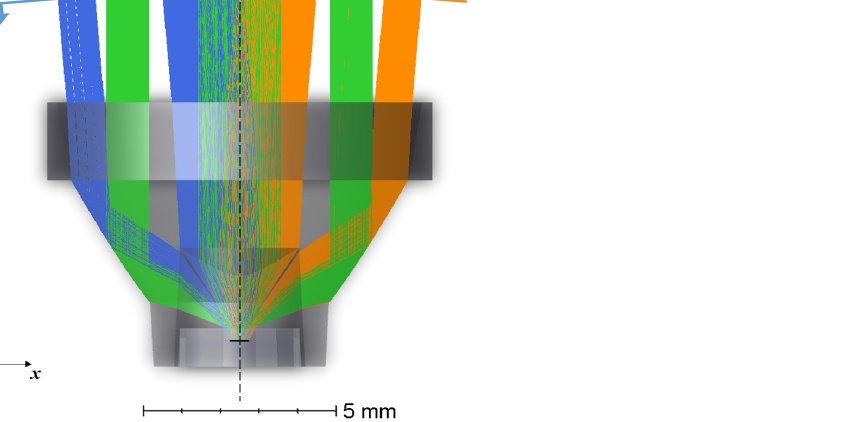
Figure 1. Cross-sectional concept render of the TIR lens and the PD. The colors indicate angles of incidence (blue: − 5°, green: 0°, orange: +5°). Only rays that hit the PD chip are shown.